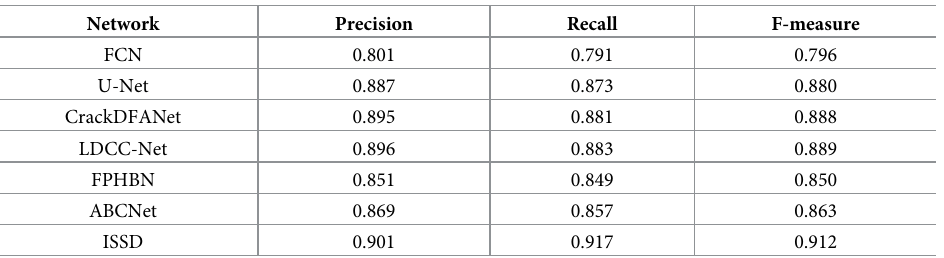
Table 5. The results of different networks on the WCD